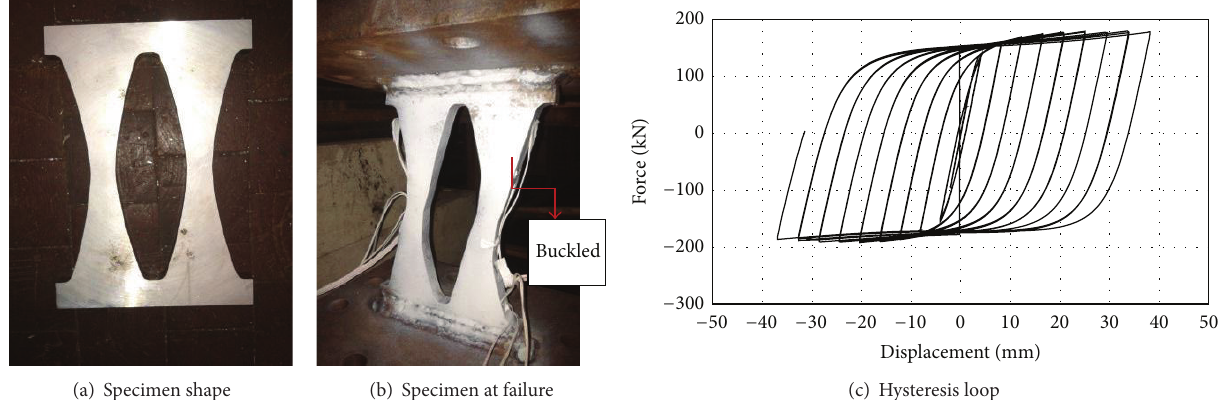
Figure 10: Results of specimen cyclic test for DHSD-2.